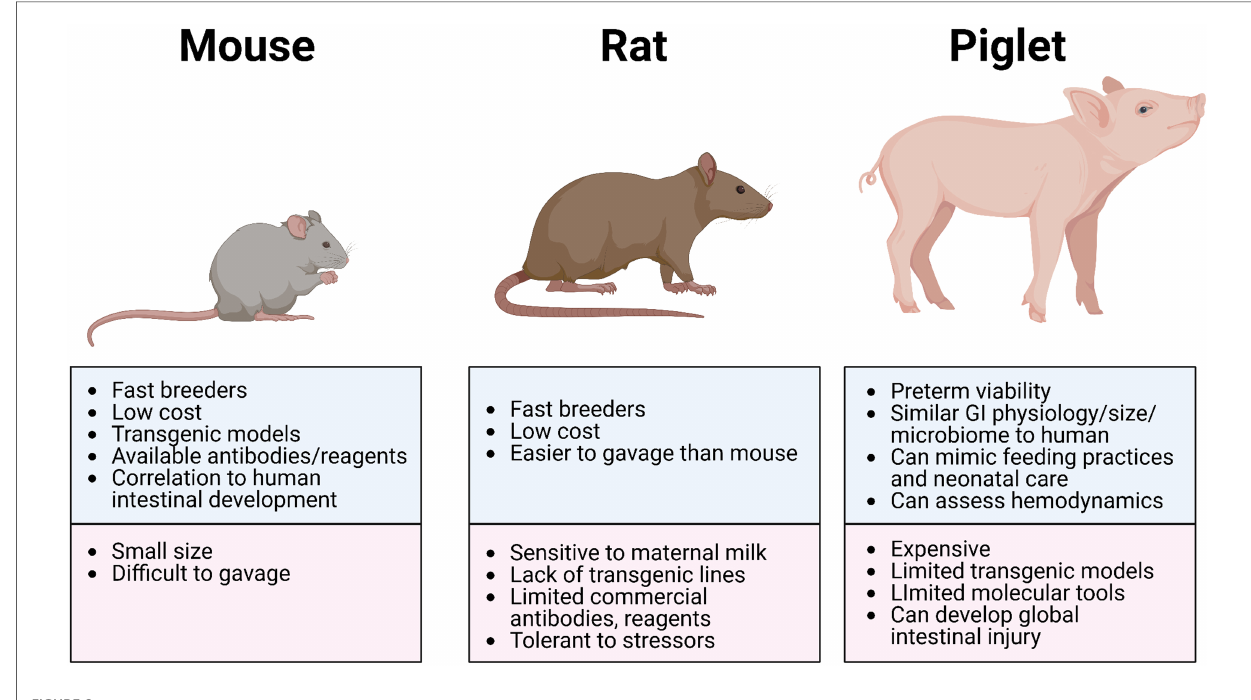
FIGURE 2 Most common animal models of NEC. Illustration created on